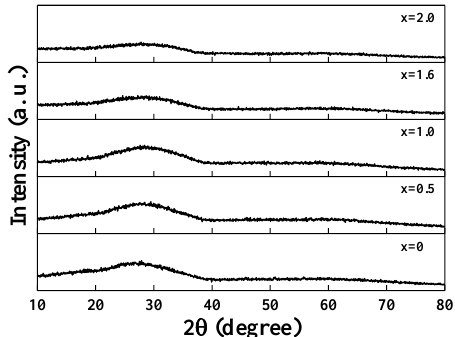
Figure 2. Selected XRD patterns of 3Li 2 O-(2-x)Fe 2 O 3 -xMn 2 O 3 -3P 2 O 5 (x = 0, 0.5, 1.0, 1.6, 2.0) glasses taken at ambient temperature.